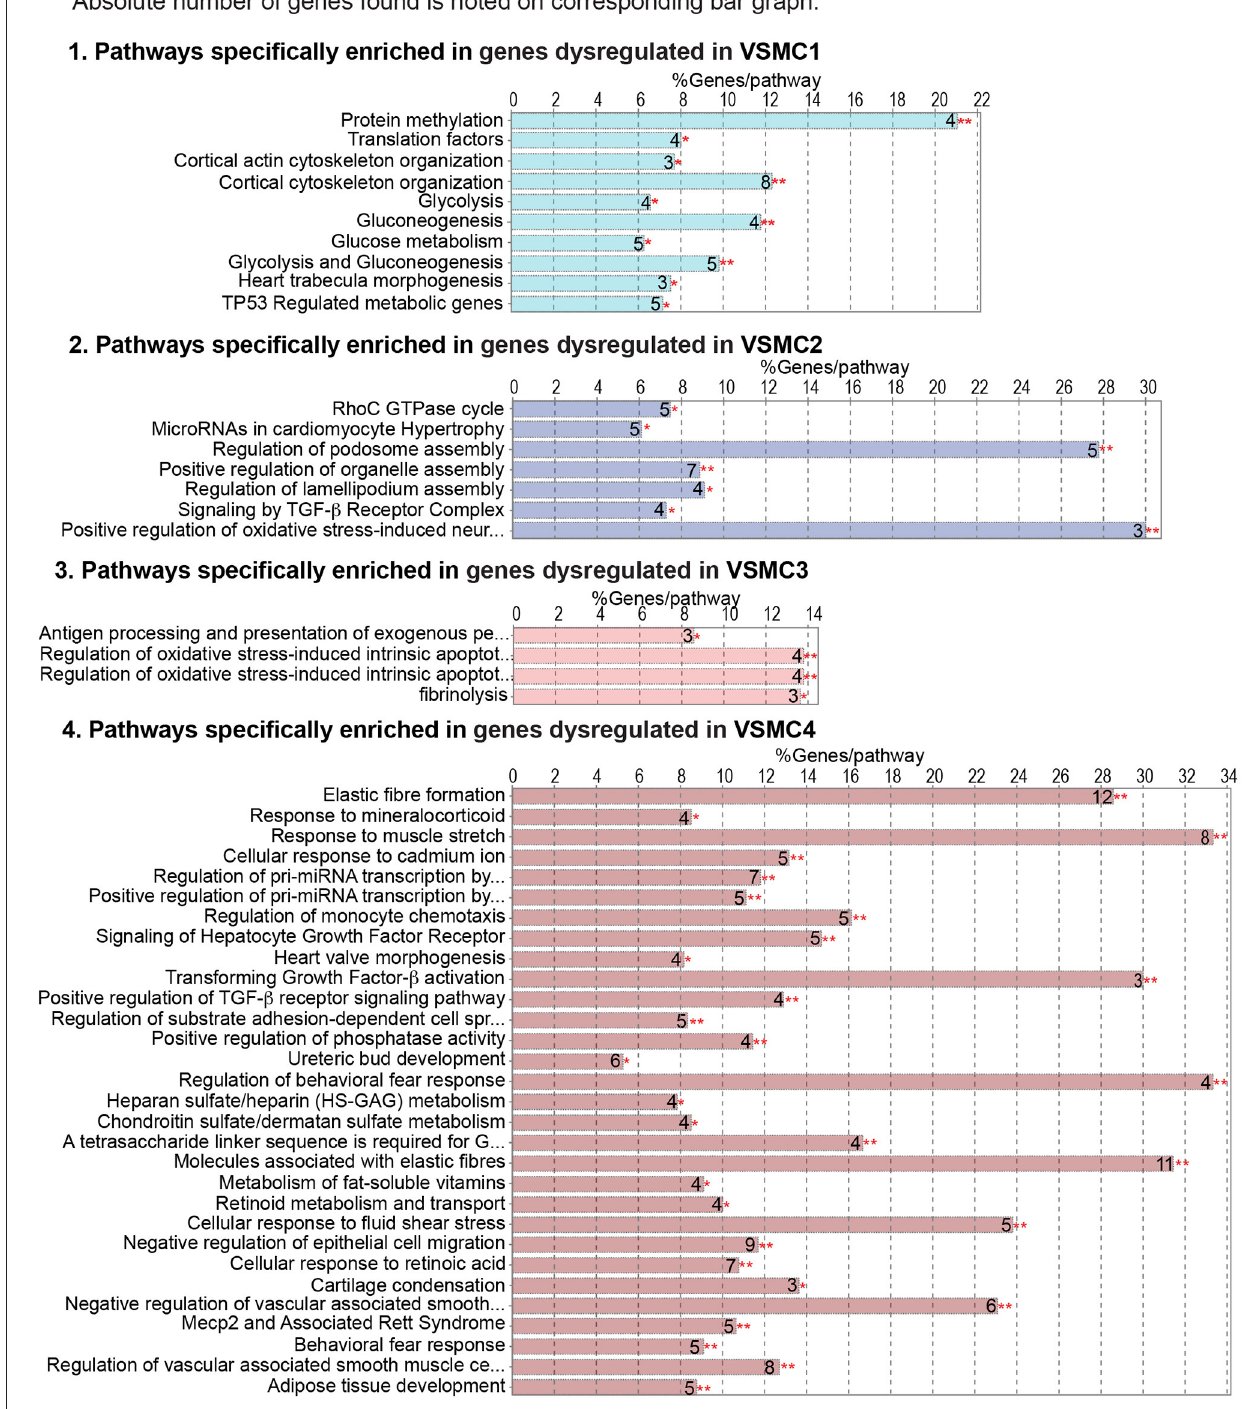
Frontiers in Cardiovascular Medicine |